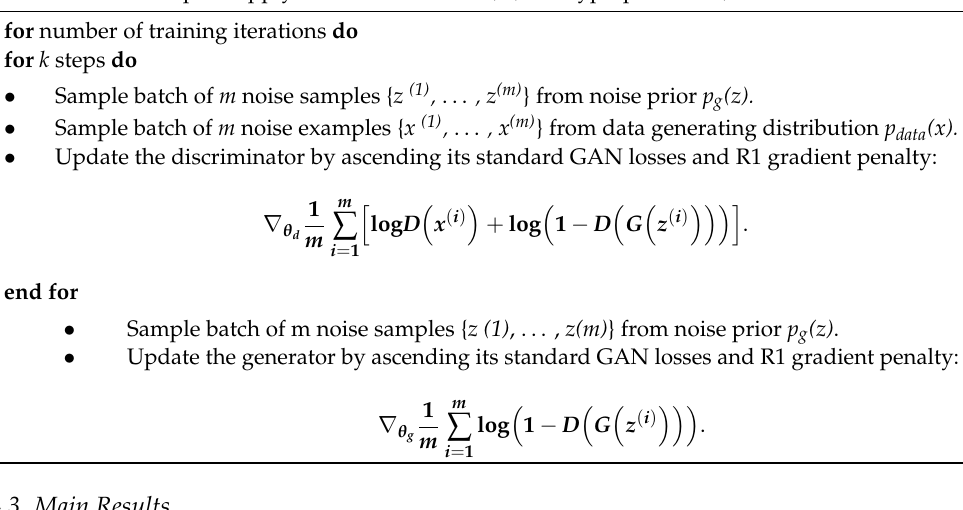
Algorithm 1 FTGH, using standard GAN losses and R1 gradient penalty to train our